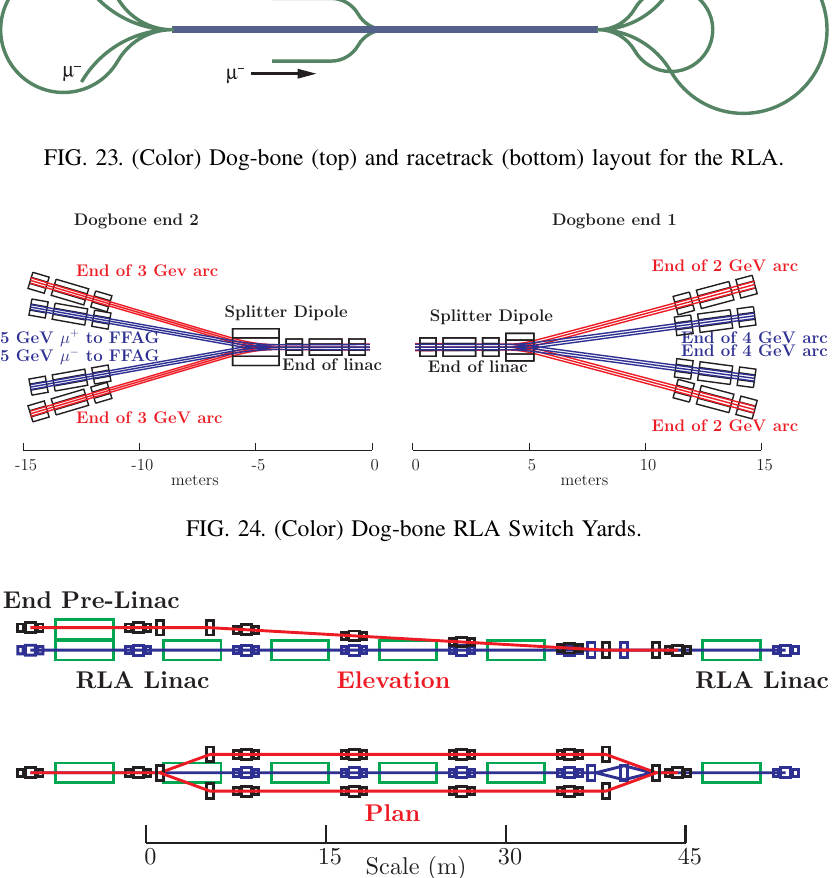
FIG. 25. (Color) Injection chicanes. Magnets in black, rf in green, RLA linac in blue, and injection lines in